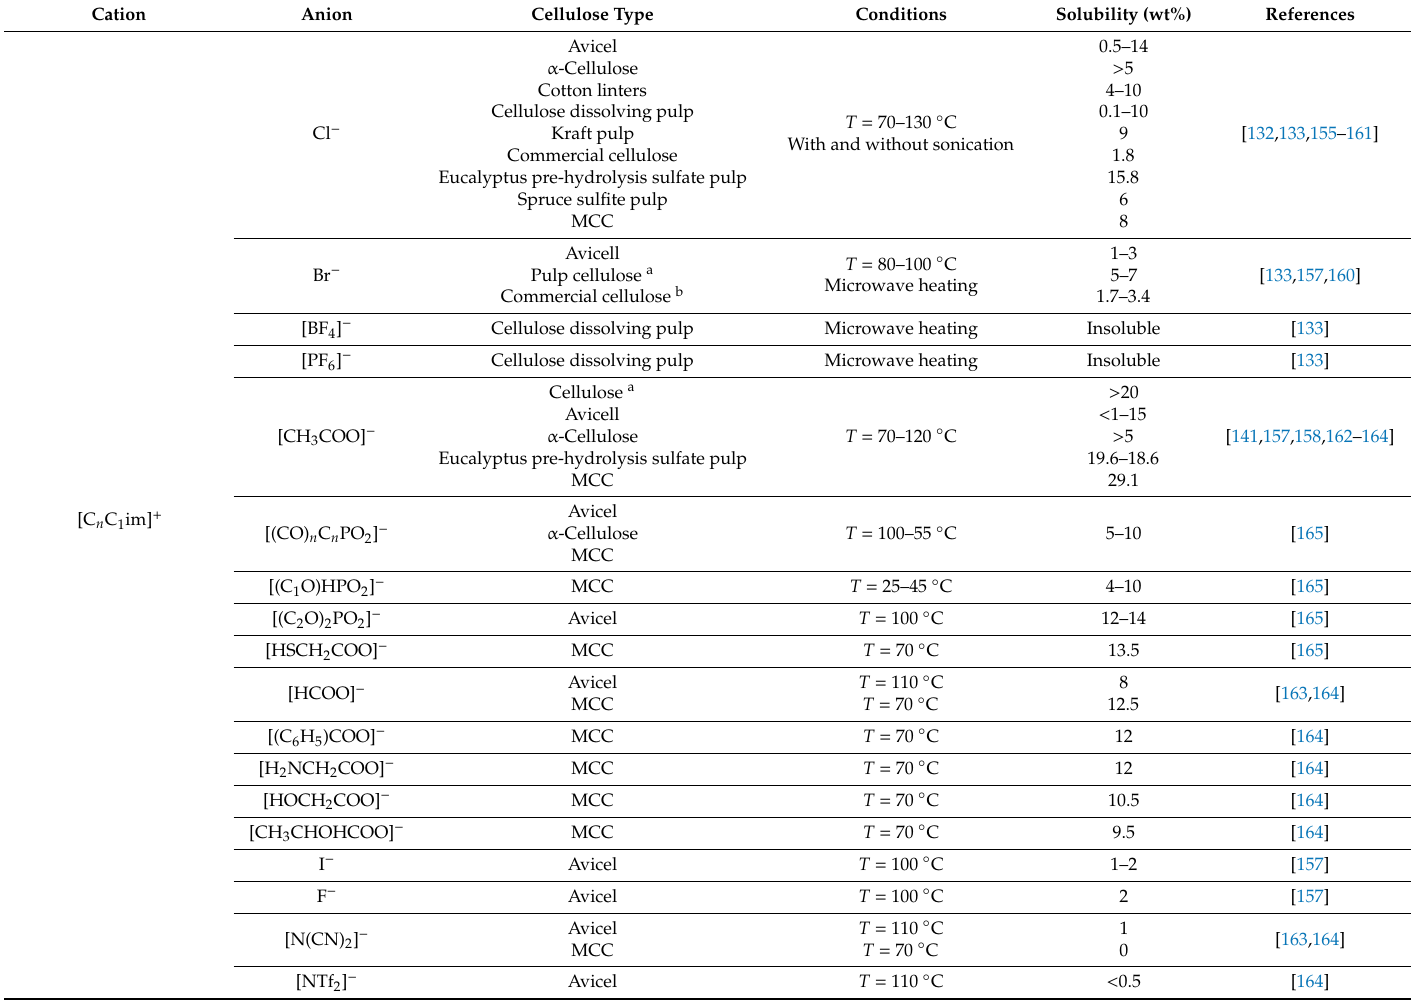
Table 4. ILs reported to dissolve cellulose, cellulose solubility and conditions